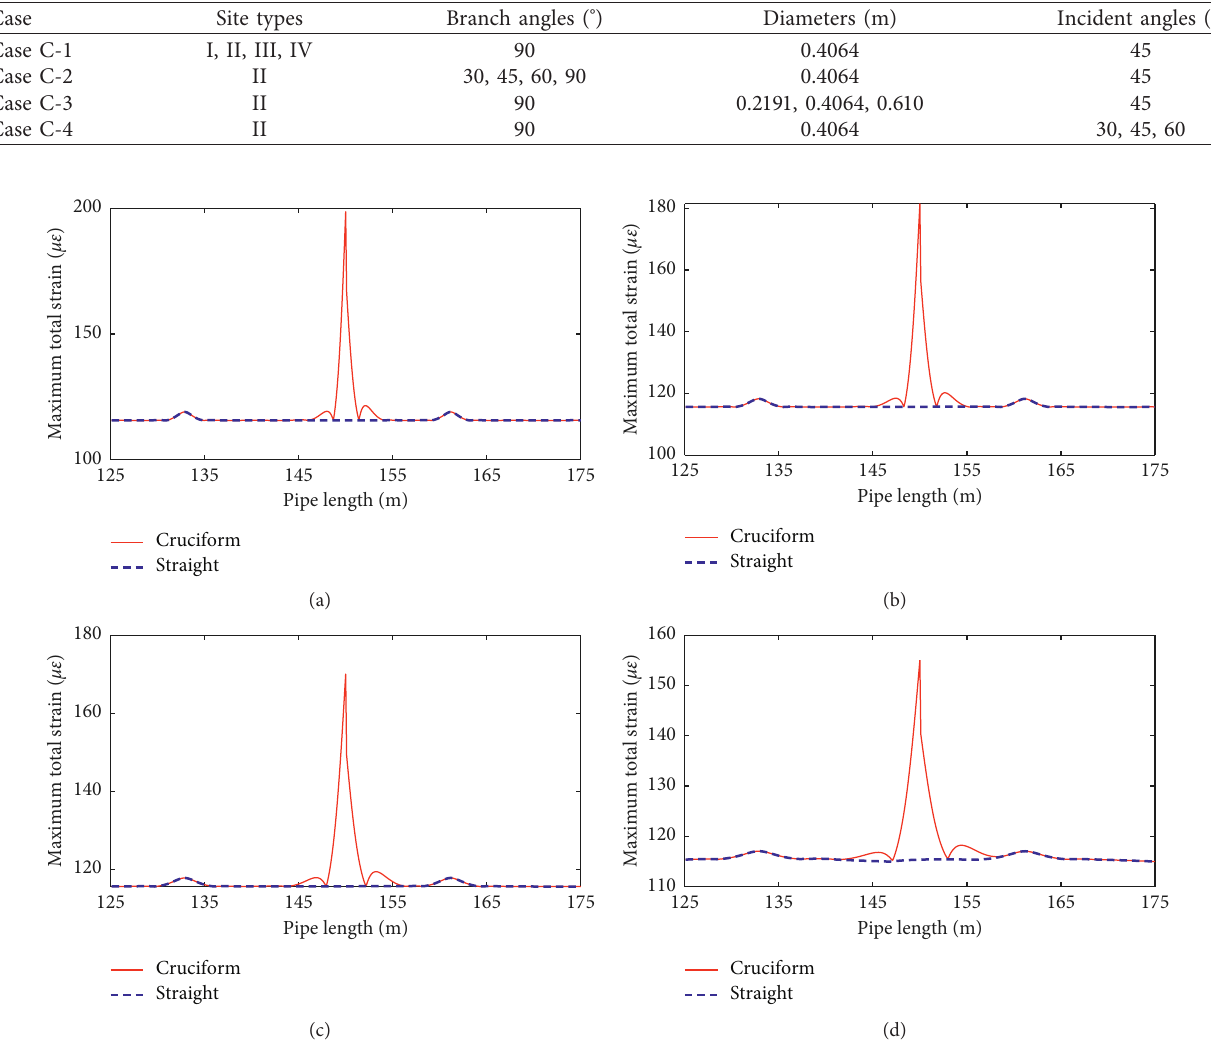
Figure 11: Maximum total strain in different site types: (a) I-site; (b) II-site; (c) III-site; (d)